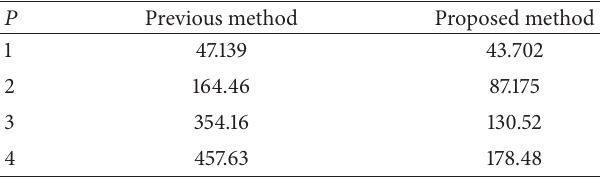
Table 3: The time cost by two methods (ms).